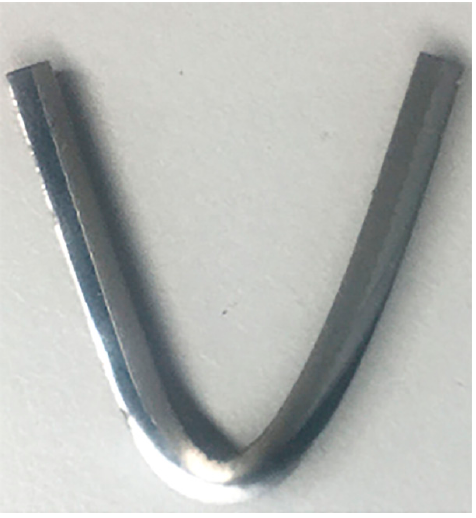
Figure 10. Macrograph of explosively welded TA1/LAS composite plate after bending up to the equipment’s limit (135 degrees).